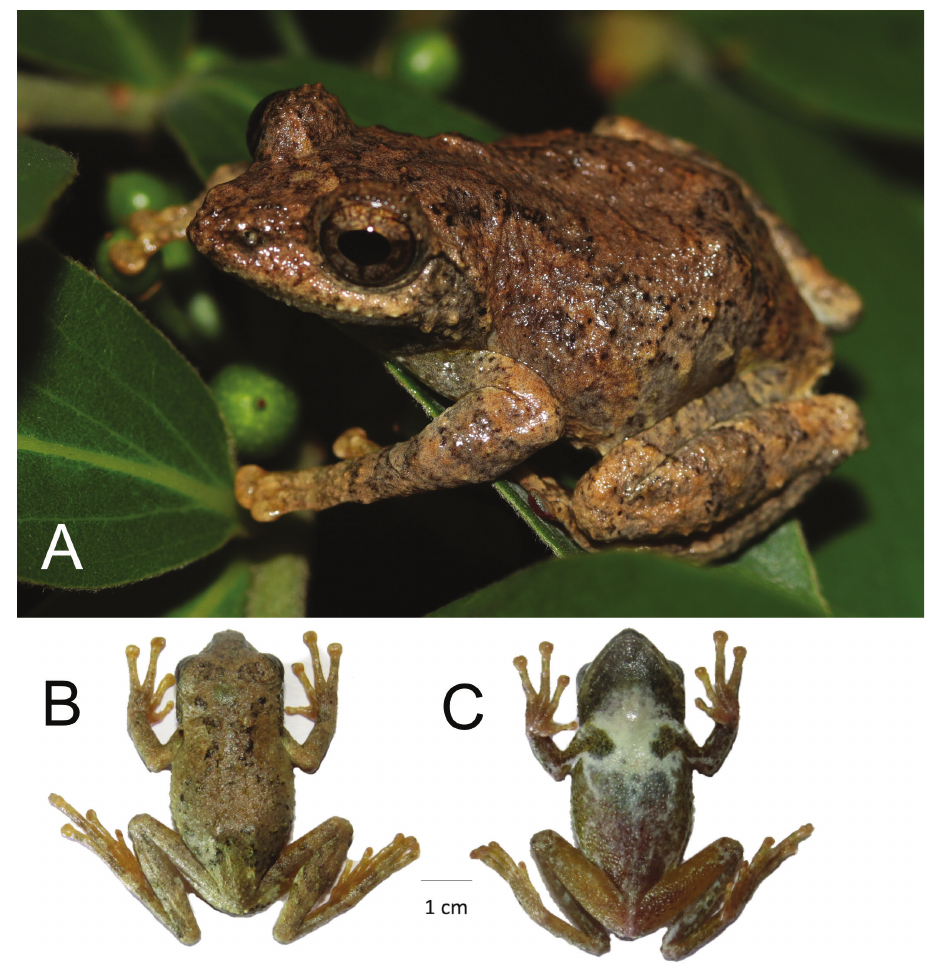
Figure 2. A Kurixalus sp. nov. specimen (HM 323117) in-situ from 26 April 2018 and B dorsal and C ventral view of